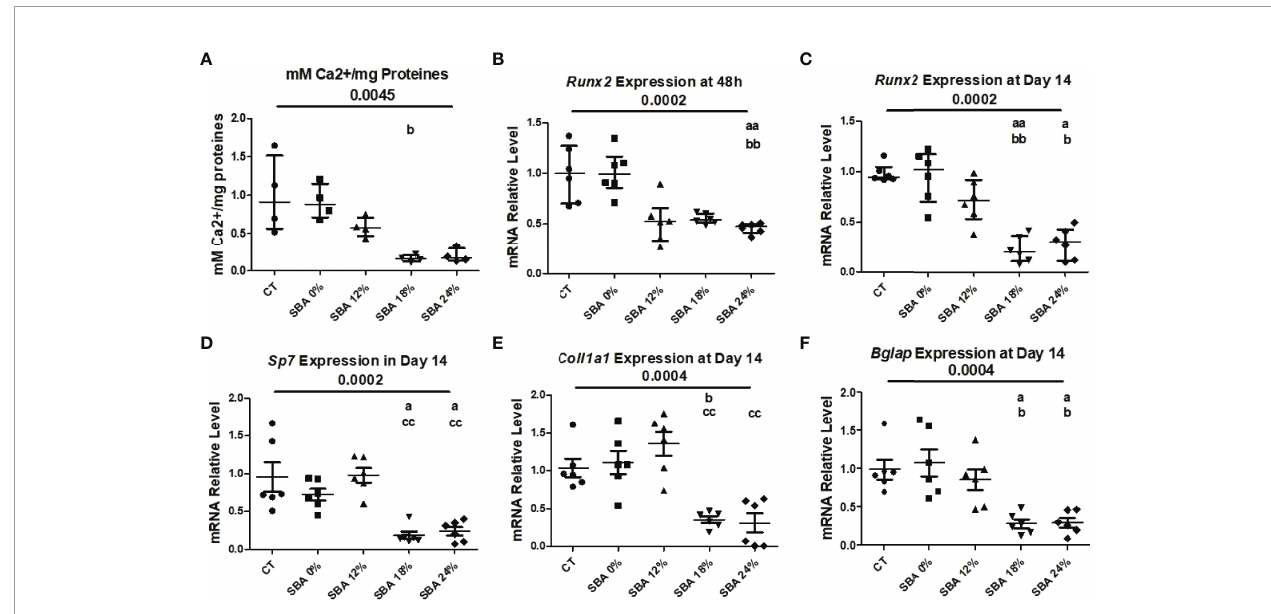
FIGURE 5 | 10-week SBA protocol induced a decrease in osteoblastogenesis. (A) Mineralization level of CT and SBA groups (0%, 12%, 18%, 24%) quanti fi ed by measuring the calcium to protein ratio; (B, C) Relative mRNA expression level of early osteoblastogenic marker gene ( Runx2 ) in CT and SBA groups (0%, 12%, 18%, 24%), cells were cultured for 48 hours in standard growth media and for 14 days were exposed to co-differentiation media, respectively; (D-F) Relative mRNA expression level of other osteoblastogenic marker genes ( Sp7, Col1a1 , and Bglap , respectively) in CT and SBA groups (0%, 12%, 18%, 24%) after exposure to co- differentiation media for 14 days. Data represent median and interquartile range; Mineralisation study n = 4, qPCR n = 6. Statistical analysis was performed using Kruskal-Wallis One-Way ANOVA test and Dunn ’ s test; a - p < 0.05, aa - p < 0.005 when compared to the CT group (b – when compared to the SBA 0% group; c – when compared to SBA 12% group). Runt-related transcription factor 2 ( Runx2 ), osterix ( Sp7 ), collagen1a1 ( Col1a1 ), osteocalcin ( Bglap ). Sirt1 is sustainably decreased in BMSCs from SBA mice (18% and 24%)